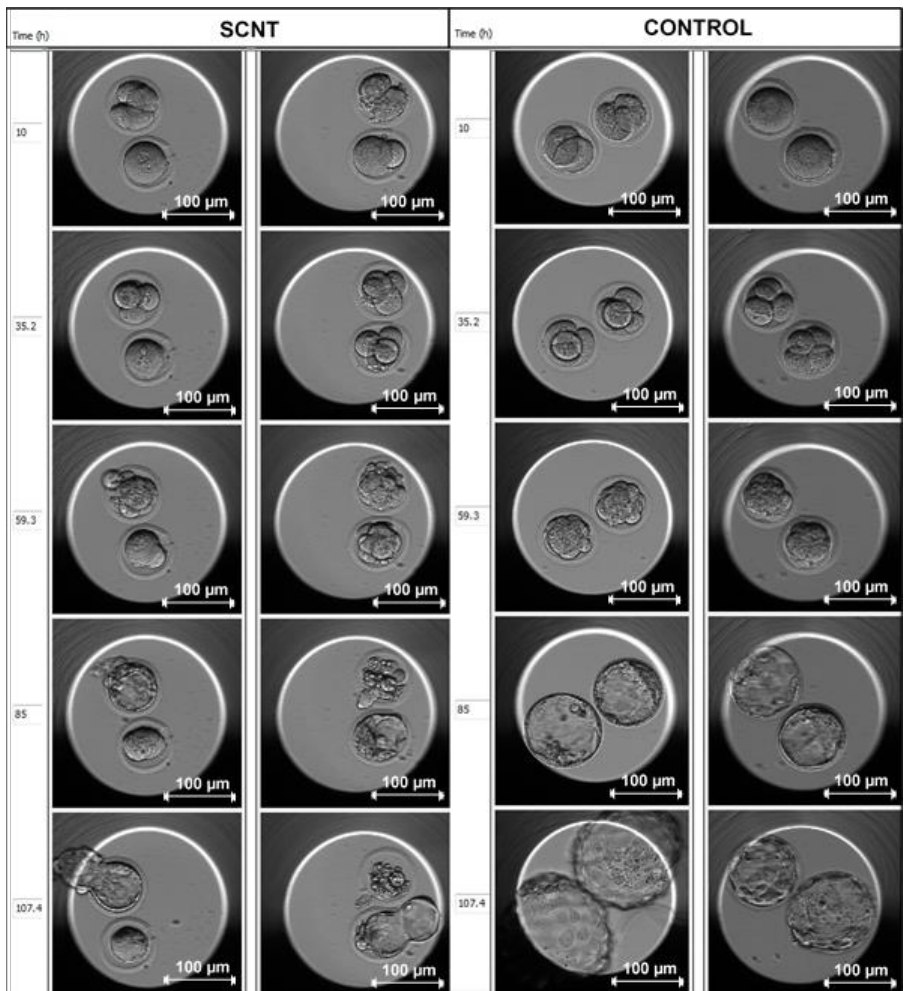
Figure 6. EmbryoScope™ time-lapse system images comparing the development of poor-quality SCNT BDF1 mouse embryos versus non-enucleated, parthenogenetic control BDF1 mouse embryos (images captured by C.G. as part of her Masters dissertation at the Reproductive Biology Laboratory, University of Pretoria).